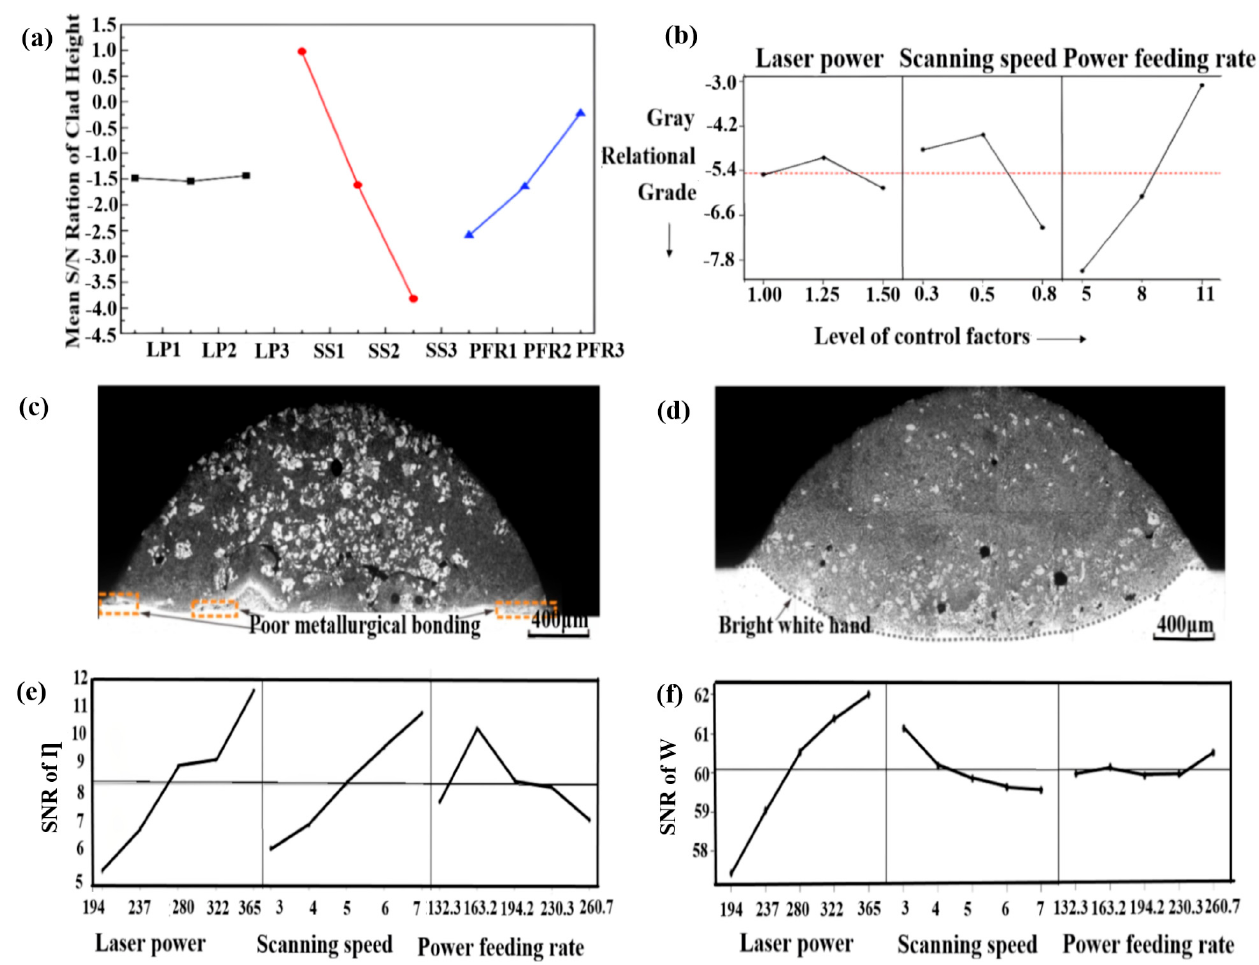
Figure 4. A grey relational graph of the process parameters, the influence of processing parameters on the signal-to-noise ratio of cladding, and the metallographic microstructure comparison of specimen cross-sections before and after optimization. ( a ) Effects of processing parameters on the S/N ratio of clad height. Reprinted with permission from Ref. [95]. 2016, Springer Nature. ( b ) Graph of grey relational grade. Reprinted with permission from Ref. [96]. 2013, Springer Nature. ( c ) Metallographic microstructure of the specimen cross-section under initial parameters. Reprinted with permission from Ref. [97]. 2022, Elsevier. ( d ) Metallographic microstructure of specimen cross-section under optimal parameters. Reprinted with permission from Ref. [97]. 2022, Elsevier. ( e ) Main effects plot for SNR of the dilution rate. Reprinted with permission from Ref. [98]. 2018, Elsevier. ( f ) Main effects plot for SNR of the clad width. Reprinted with permission from Ref. [98]. 2018, Elsevier.